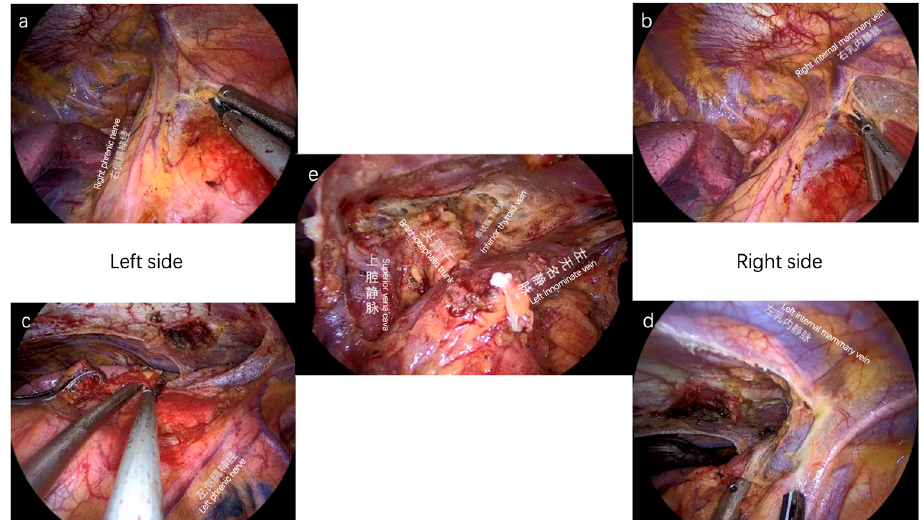
Figure 2. Increased retrosternal space is created by our sternum-lifting system. The relevant anatomy is easily identified, and more complex dissection can be achieved. ( a ) The right phrenic nerve; ( b ) The right internal mammary vein; ( c ) The left phrenic nerve; ( d ) The left internal mammary vein; ( e ) Superior vena cava, brachiocephalic trunk, inferior thyroid vein, left innominate vein.